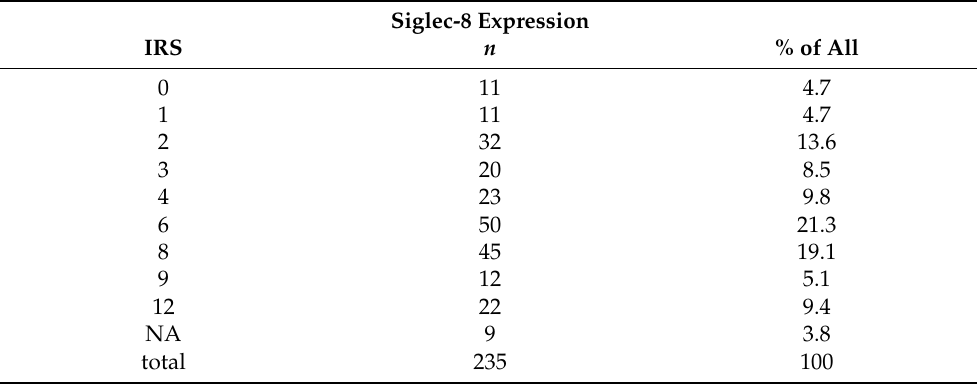
Table 1. Staining results of Sialic Acid Binding Ig Like Lectin 8 (Siglec-8). IRS = immune reactivity score. NA = not applicable, staining could not be evaluated due to technical